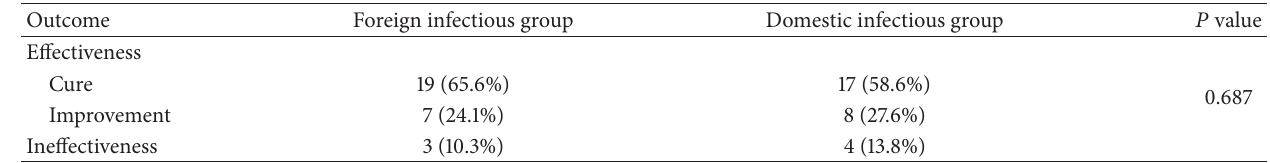
Table 3: Surgical outcome of infectious keratitis between the two groups.